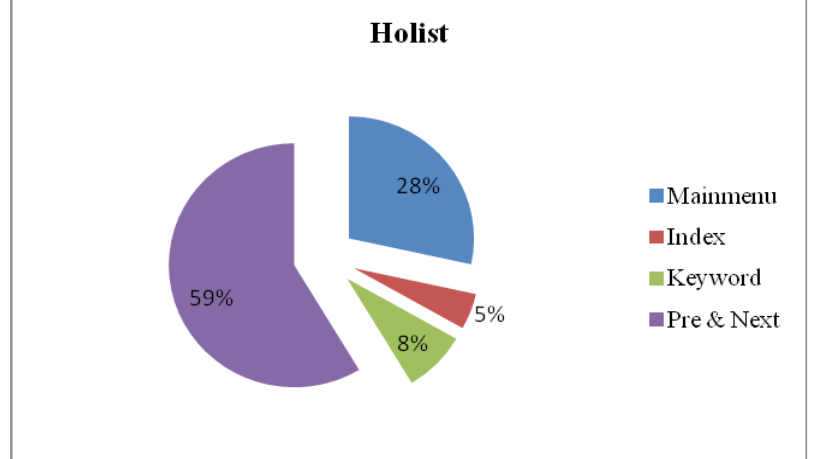
Figure 4. The tools used by Holists